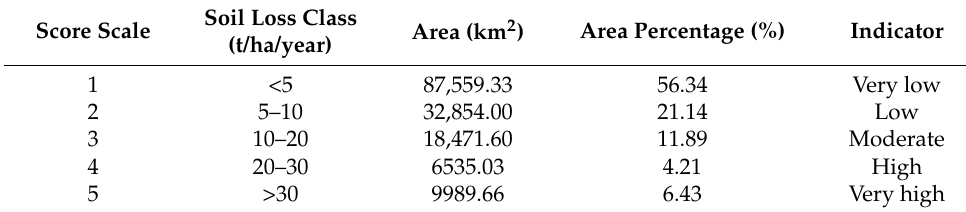
Table 4. Soil loss